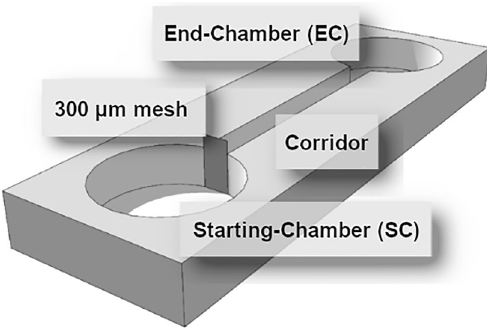
Figure 1. Design of the testing arenas.